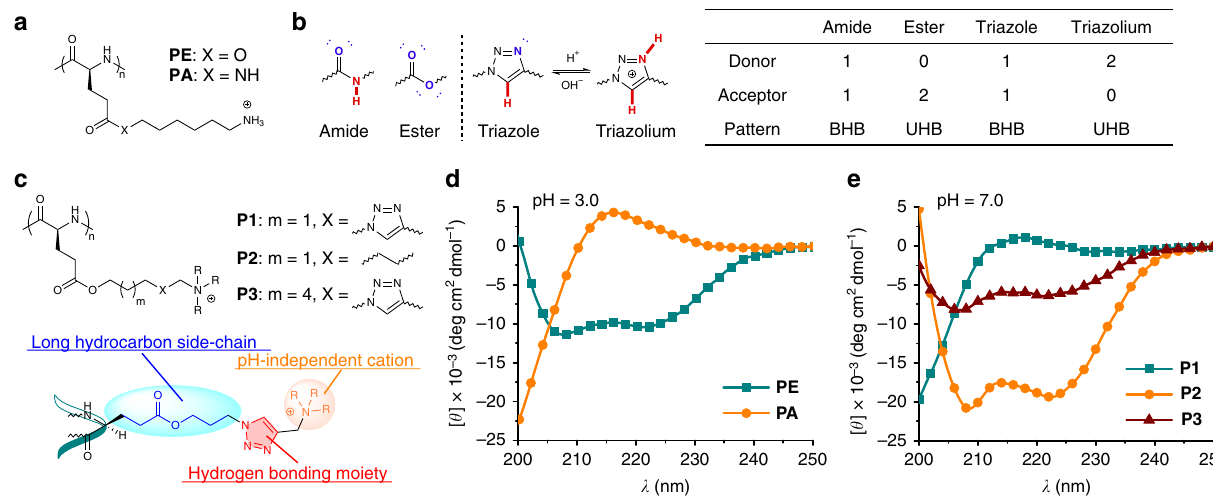
Fig. 2 Side-chain triazole groups disrupt the backbone α -helical conformation. a Chemical structures of PE and PA . b H-bonding pattern analysis of amide, ester, 1,2,3-triazole, and 1,2,3-triazolium. H-bond donors and acceptors are highlighted in red and blue , respectively. c Chemical structures of P1 - P3 . The molecular design of triazole polypeptides is highlighted, where each component is essential for the study. d , e CD spectra of polypeptides. PE and PA were analyzed at pH 3.0 ( d ), and P1 - P3 were analyzed at pH 7.0 ( e )